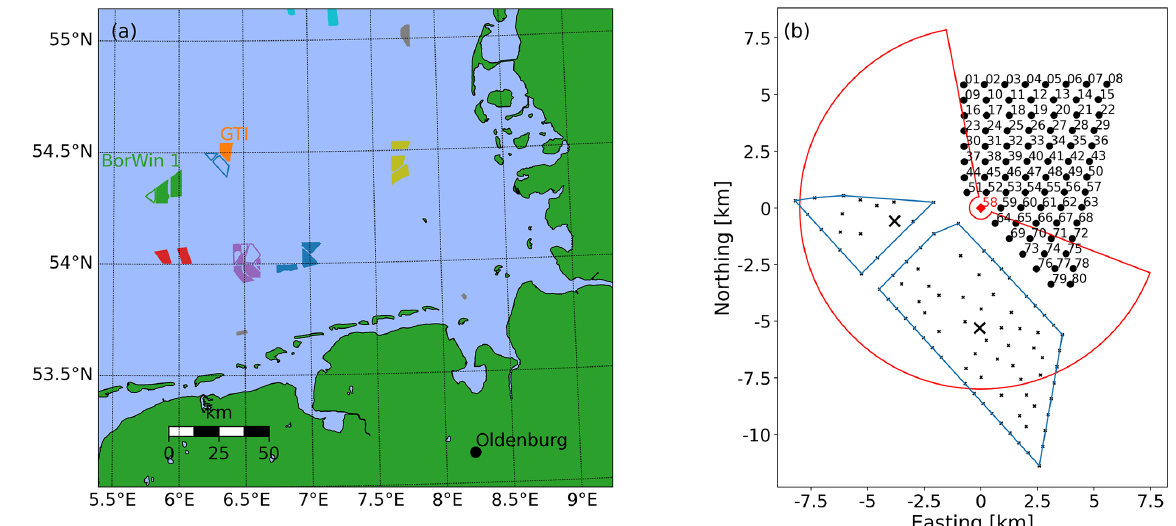
Figure 1. (a) Location of the wind farm GT I (orange) in the North Sea with neighbouring wind farms and clusters shown. Wind farms under construction are depicted as open shapes (status beginning of 2019). The 24km upstream BorWin 1 cluster is marked in green. (b) Layout of GT I ( • with turbine numbers). The position of the lidar on turbine GT58 (red filled (cid:5) ) and the lidar scan region covering the area of the four different 150 ◦ scan sectors (red line) are highlighted. The turbine locations (small × ) and the substations ( × ) of the wind farms Hohe See (southerly blue shape) and Albatros (northerly blue shape), which were under construction during our measurements, are